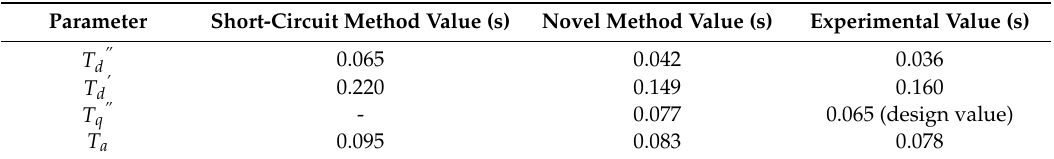
Table 6. Comparison of transient time constant